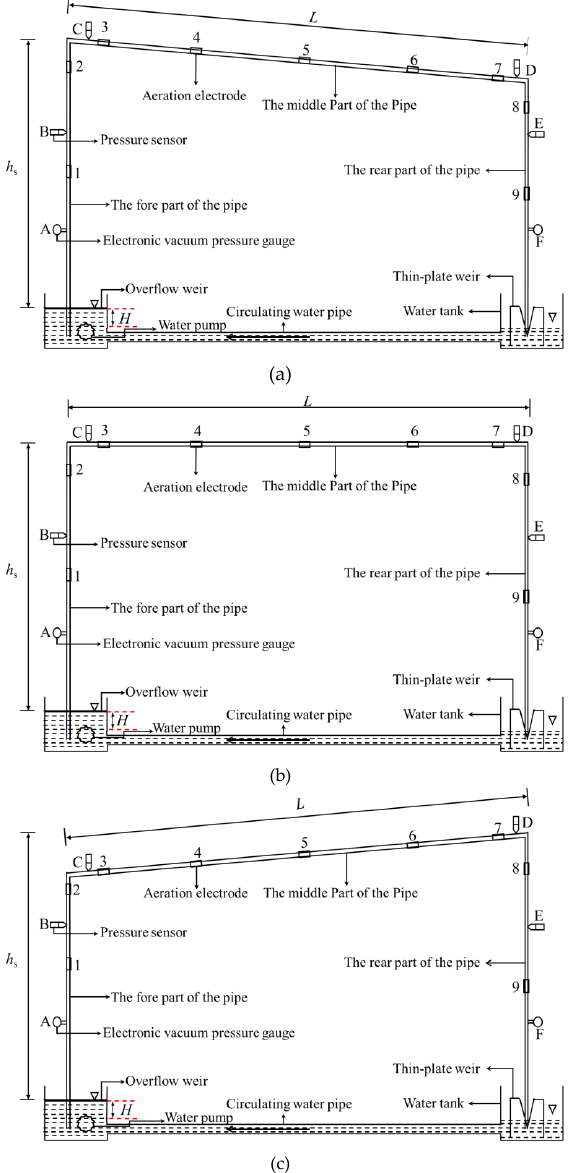
Figure 1. Layout of test devices: ( a ) pipeline on the positive slope, ( b ) pipeline on the flat slope, ( c ) pipeline on the reverse slope.Note: 1–9 refer to aeration electrodes; A, F refer to electronic vacuum pressure gauges; B, C, D, E refer to pressure sensors; L refers to the length of the middle part of the siphon pipe (m); h s refers to the installation height